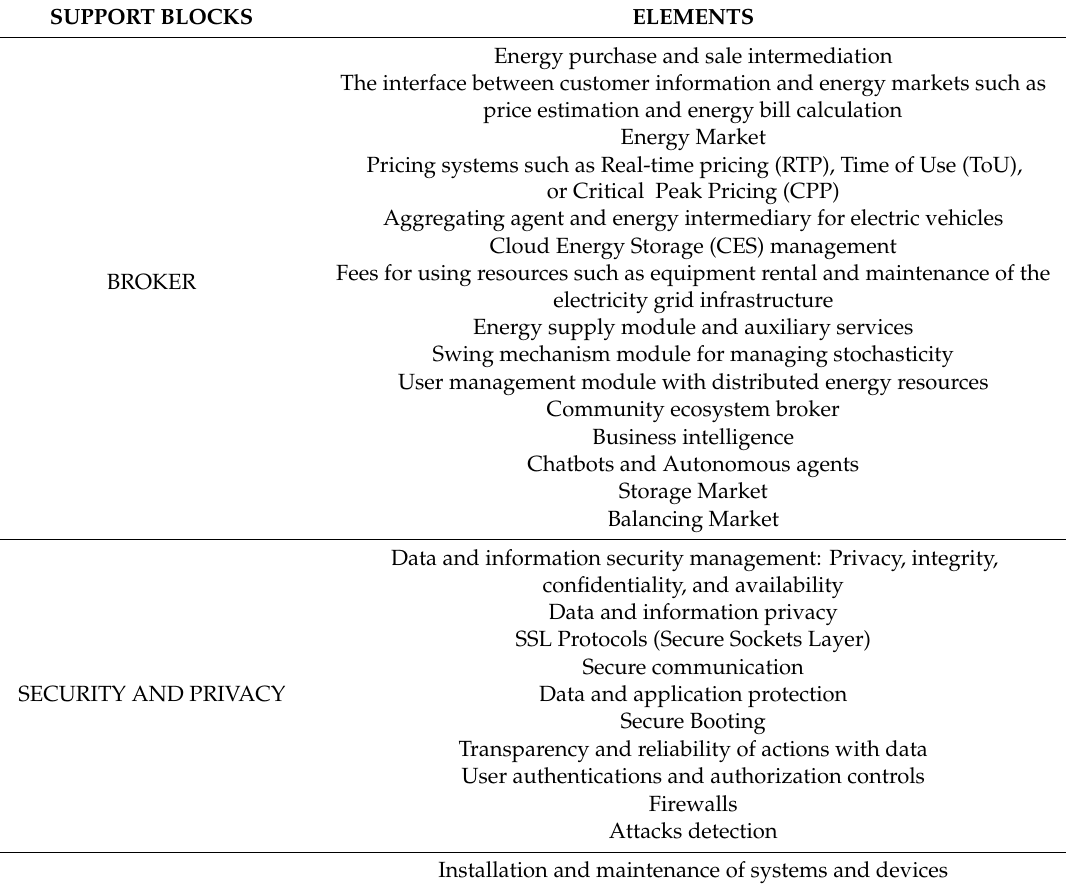
Table 6. Support block